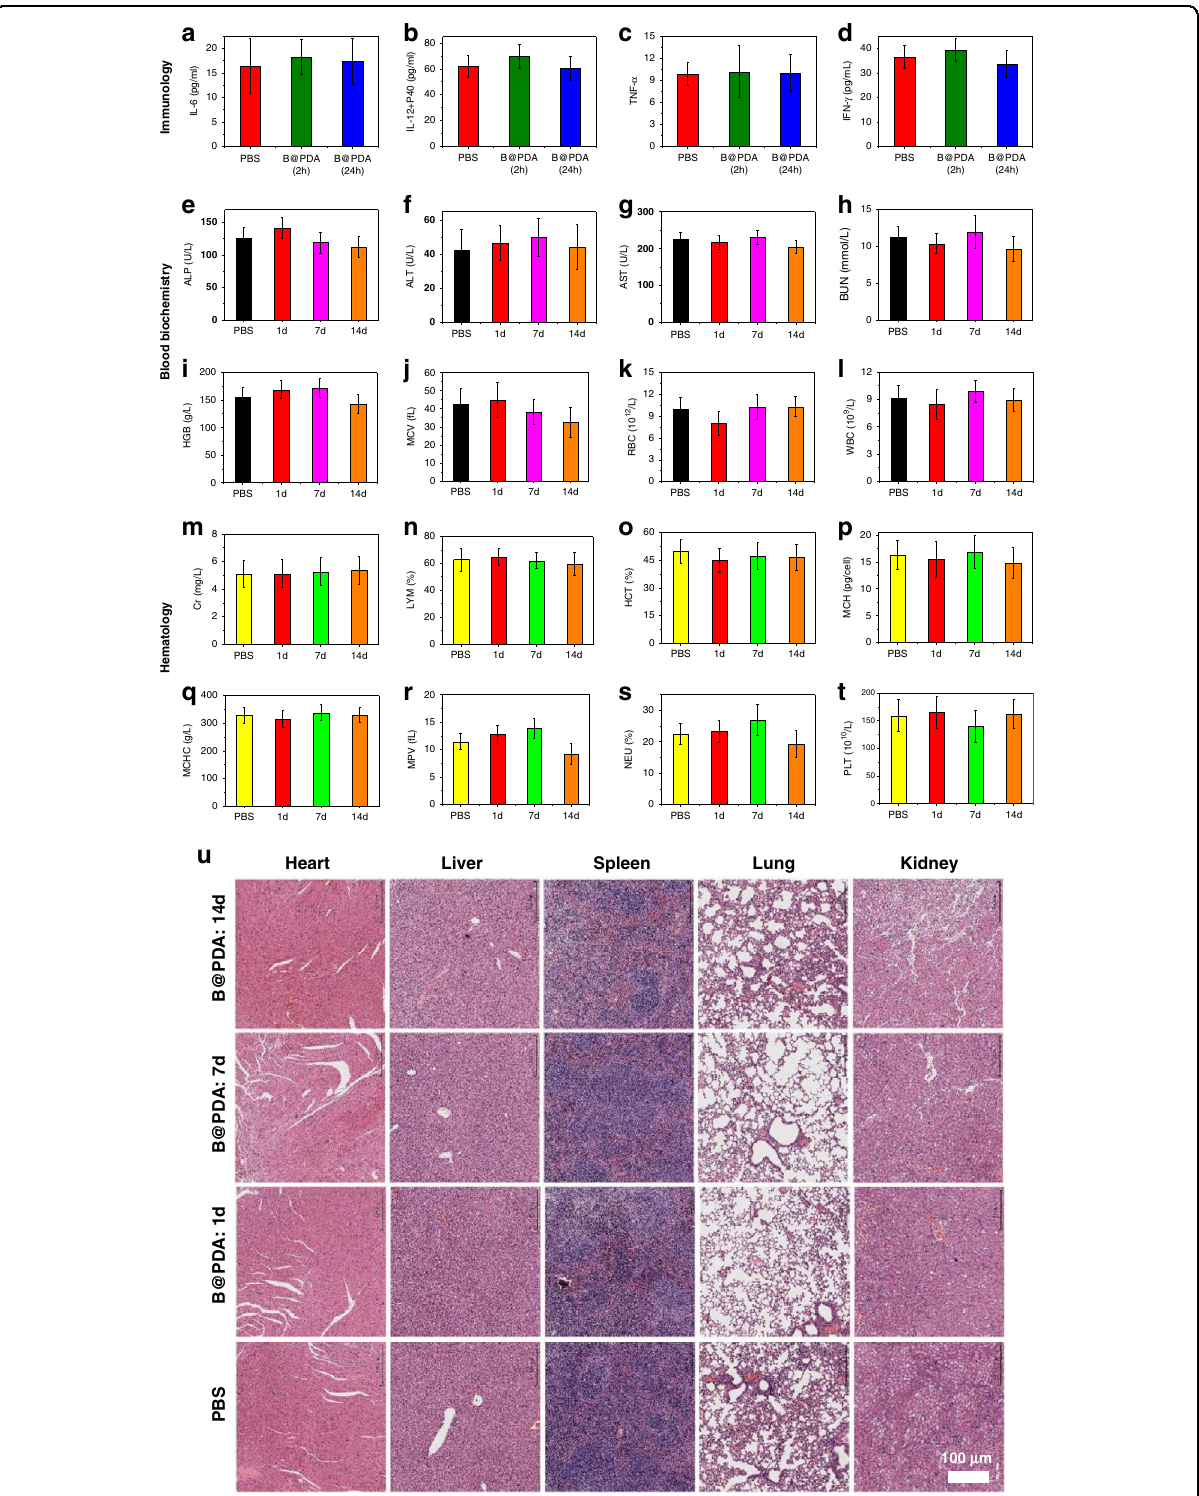
Fig. 9 In vivo toxicity test. All the parameters are for healthy BALB/c mice injected with B@PDA and PBS. a – d Serum levels of immunology index. e – t Blood hematology and biochemistry data were collected after intravenous injection. u H&E staining of major